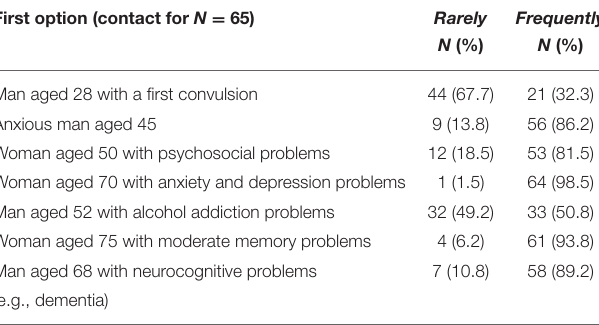
TABLE 4 | Reported categories of patients who contact their GP as the first health care provider for different mental health care problems. First option (contact for N =